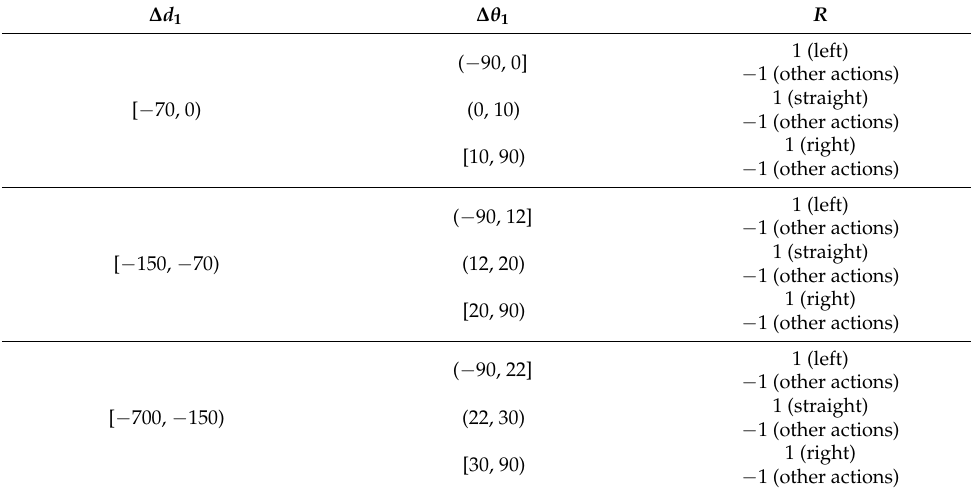
Table 4. Reward and punishment values for the right side of the planning